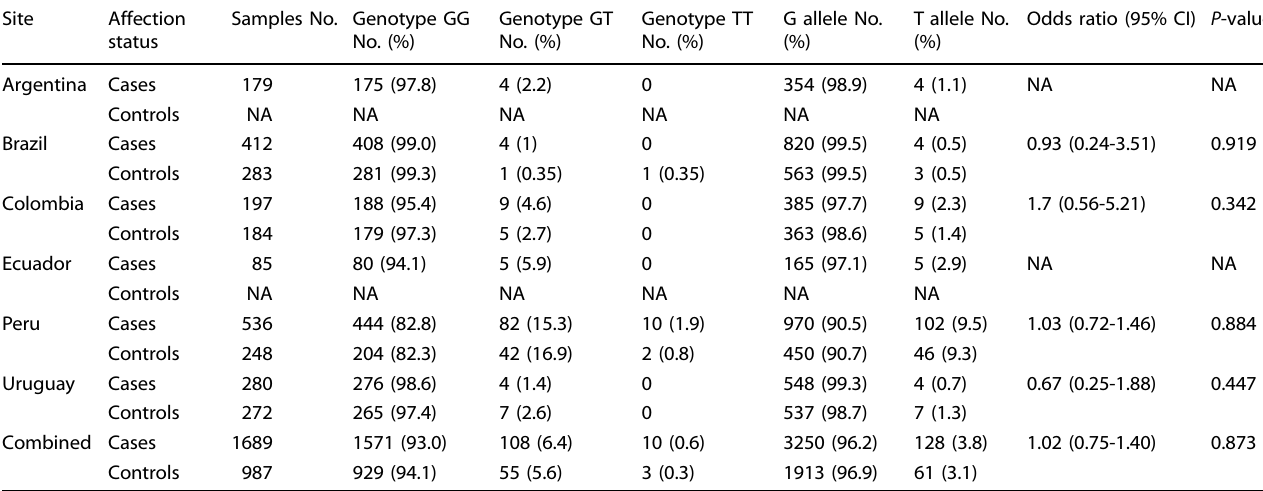
Table 2. Allele and genotype frequencies of LRRK2 p.Q1111H